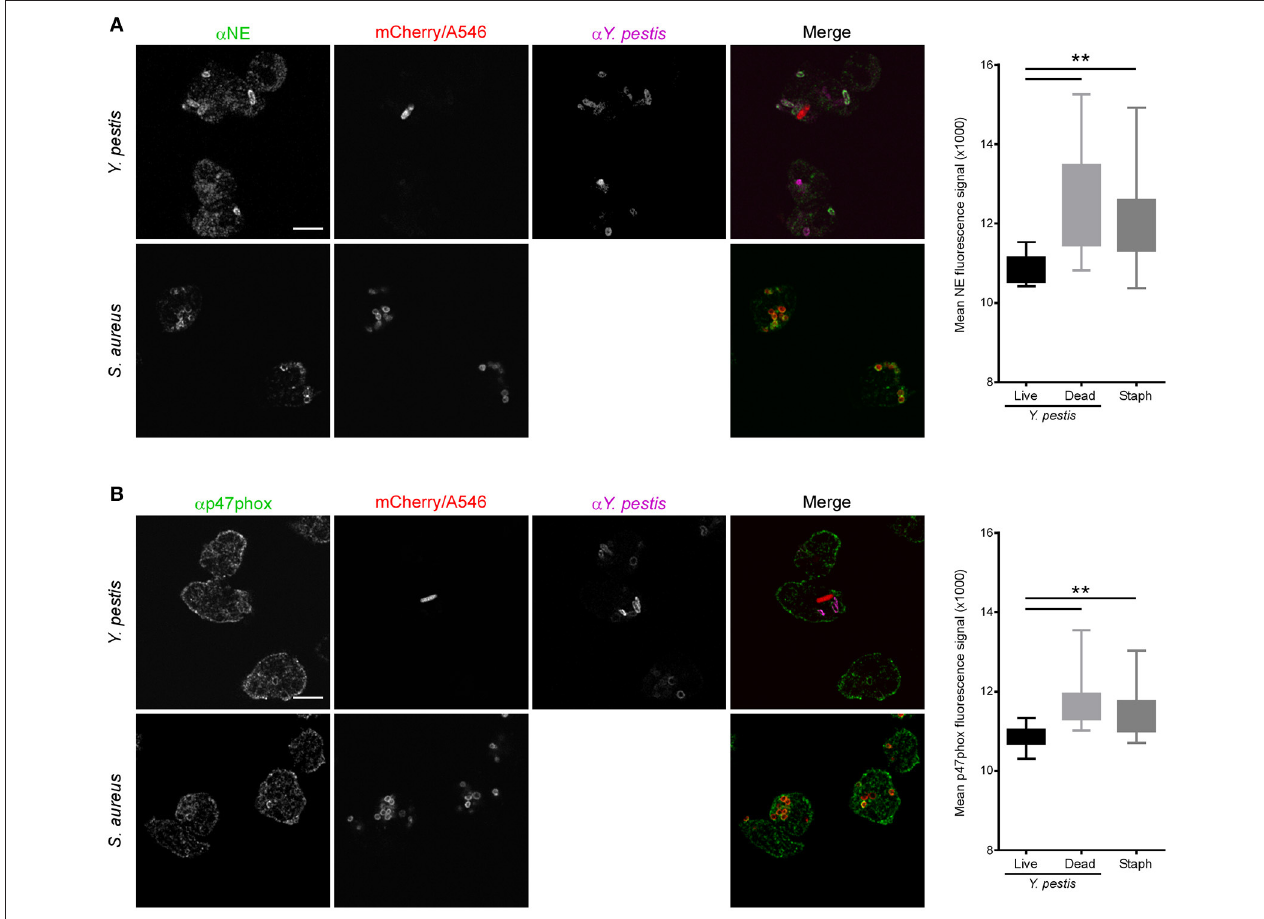
FIGURE 6 | Neutrophil phagosomes containing live Y. pestis show reduced association with p47phox and neutrophil elastase. Neutrophils were infected with Y. pestis KIM6 + pTac-mCherry or Alexa546-labeled S. aureus on fibronectin-coated glass coverslips. At 15min post-infection gentamicin was added to the medium to kill remaining extracellular bacteria. At 30min post-infection the medium was removed and replaced with fresh medium without gentamicin, but with 300 µ M IPTG. Cells were cultured for an additional 90min to induce mCherry expression in remaining live Y. pestis . Coverslips were fixed, stained for IFA with antibodies against Y. pestis and (A) neutrophil elastase (NE), or (B) p47phox, and imaged by confocal microscopy. Live Y. pestis were identified by bright mCherry signal. Anti- Y. pestis staining was used to identify dead Y. pestis . We did not distinguish between live or dead S. aureus . Images are representative of 10 separate micrographs for each condition. Scale bar represents 5 µ m. The box and whisker plots to the right of each set of panels show combined data for fluorescence intensity surrounding live Y. pestis , dead Y. pestis or S. aureus phagosomes. Differences in fluorescence intensities were determined by one-way ANOVA followed by Holm-Sidak’s multiple comparisons test. The box represents 25–75 percentile, the whiskers represent minimum and maximum values. ** p <